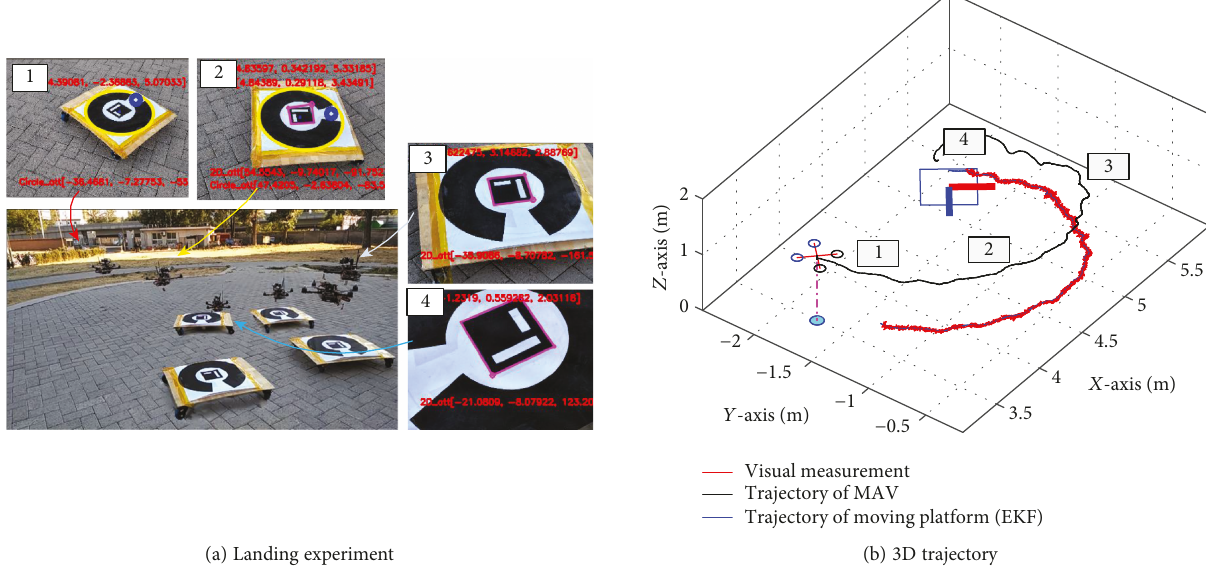
Figure 11: Circular motion landing experiment.